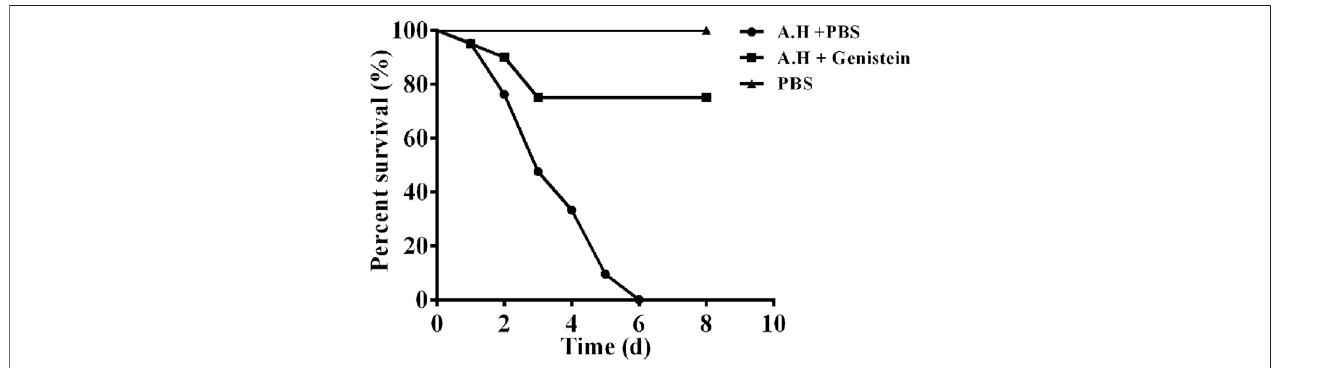
FIGURE 6 | Genistein treatment improved the survival rate of channel cat fi sh infected with A. hydrophila . Fish infected with A. hydrophila were treated with 20 mg/kg genistein or sterile PBS every 12 h for 3 days, deaths were observed for 8 days after infection. Treatment with genistein could provide a signi fi cant protection to fi sh challenged with A. hydrophila when analyzed by log-rank test ( p < 0.0001).